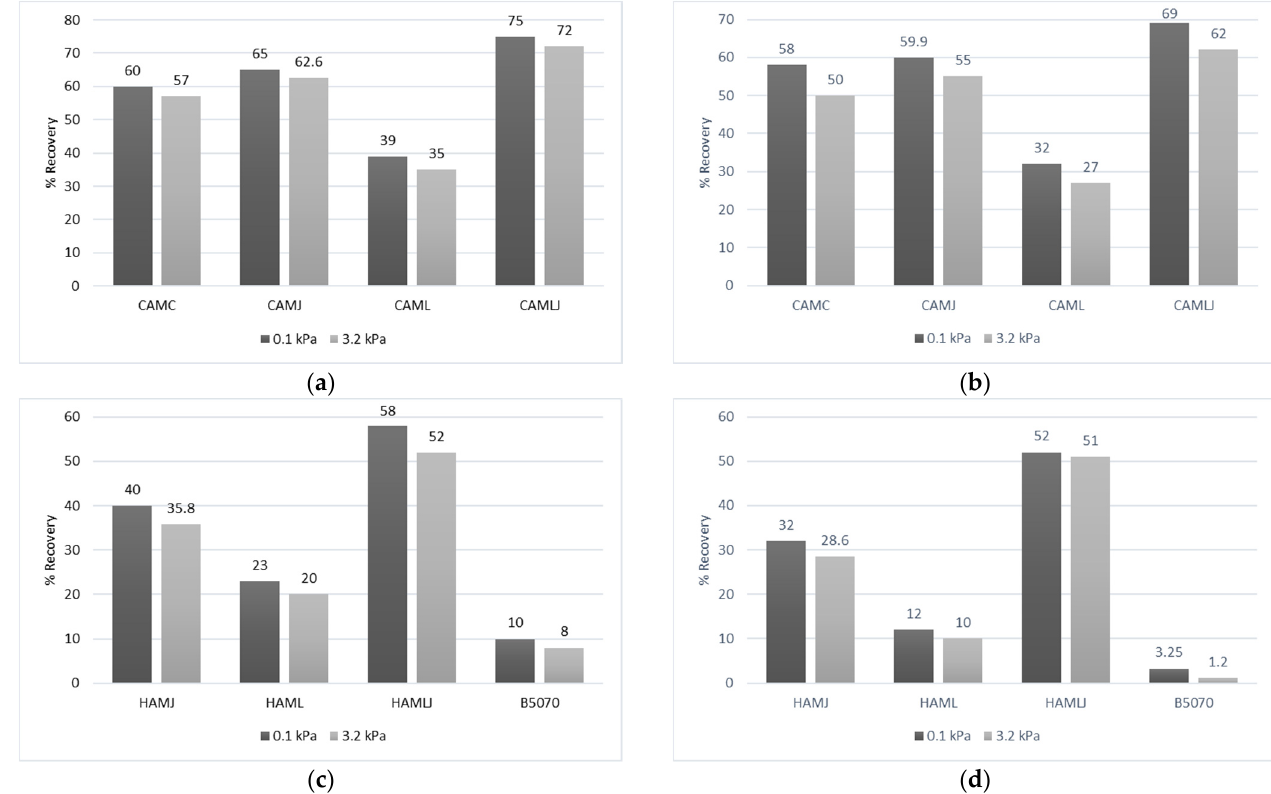
Figure 14. Percent recovery results: ( a ) cold asphalt mastics at 40 °C, ( b ) cold asphalt mastics at 50 °C, ( c ) hot asphalt mastics at 40 °C, and ( d ) hot asphalt mastics at 50 °C.